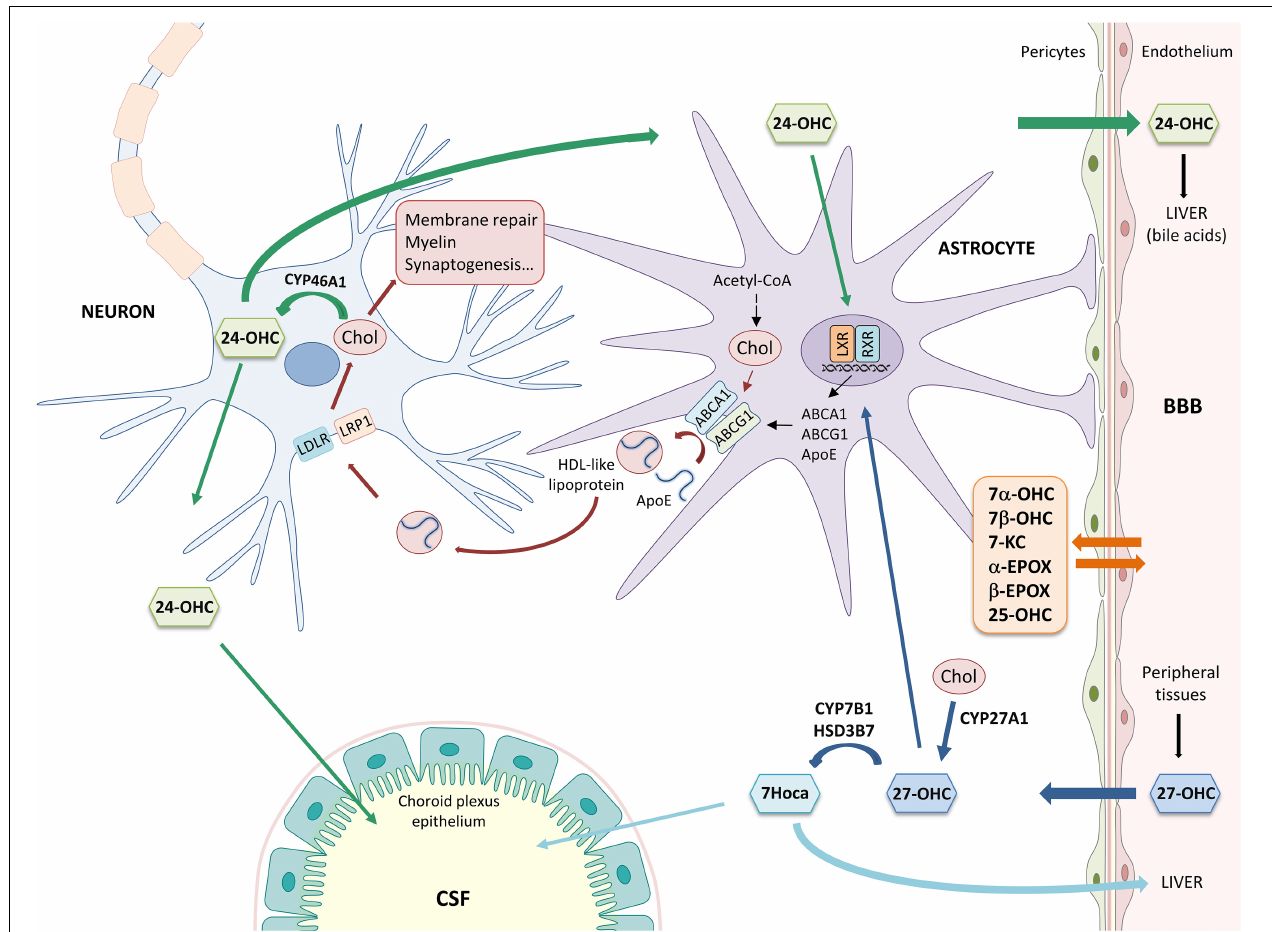
FIGURE 1 | Main mechanisms involved in brain cholesterol homeostasis. α -EPOX, 5 α ,6 α -epoxycholesterol; β -EPOX, 5 β ,6 β -epoxycholesterol; 24-OHC, 24-hydroxycholesterol; 25-OHC, 25-hydroxycholesterol; 27-OHC, 27-hydroxycholesterol; 7 α -OHC, 7 α -hydroxycholesterol; 7 β -OHC, 7 β -hydroxycholesterol; 7Hoca, 7 α -hydroxy-3-oxo-4-cholestenoic acid; 7-KC, 7-ketocholesterol; ABC, ATP-binding cassette; Acetyl-CoA, acetyl coenzyme A; ApoE, apolipoprotein E; BBB, blood-brain barrier; Chol, cholesterol; CSF, cerebrospinal fluid; HDL, high density lipoprotein; HSD3B7, 3 β -hydroxy-C27-steroid dehydrogenase/isomerase; LDLR, low density lipoprotein receptor; LRP1, LDL receptor-like protein 1; LXR, liver X receptor; and RXR, retinoid X